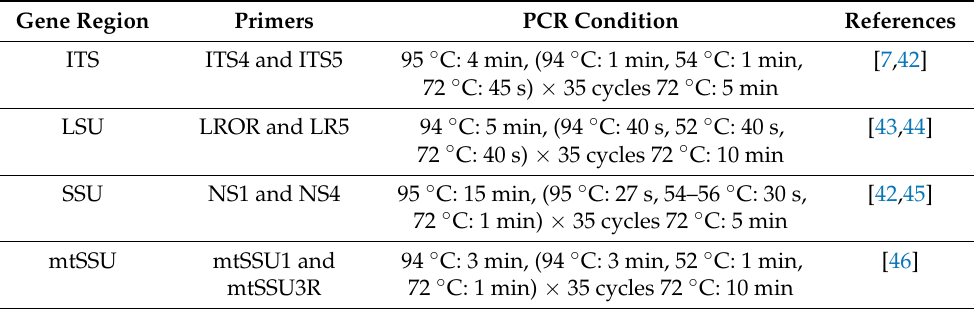
Table 1. Gene regions, respective primer pairs and PCR conditions used in the study. Gene